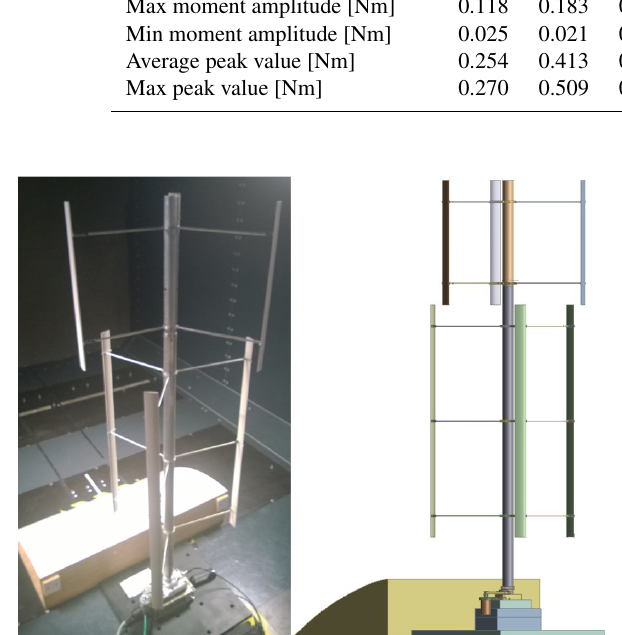
Figure 5. Model set in configuration A.